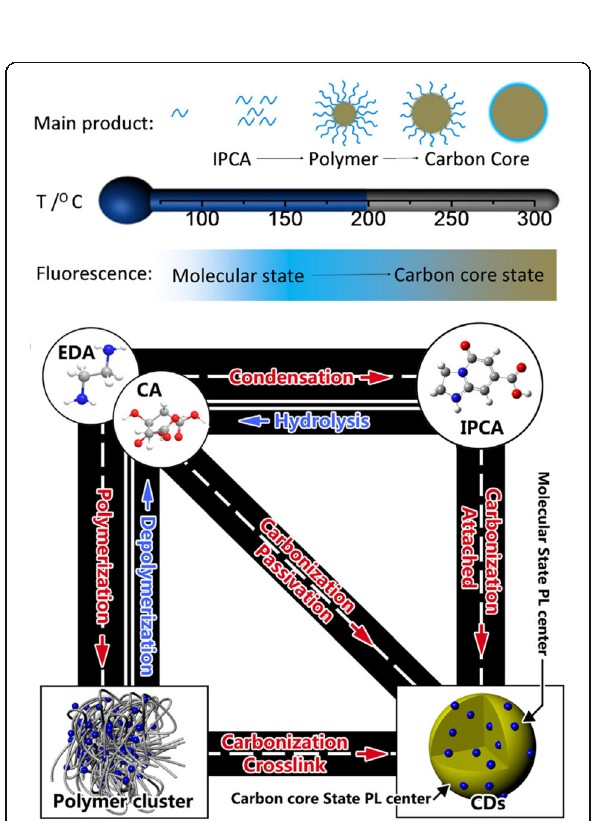
Fig. 3 a Scheme showing bottom-up formation of CDs at different temperatures and b the relationship between different products